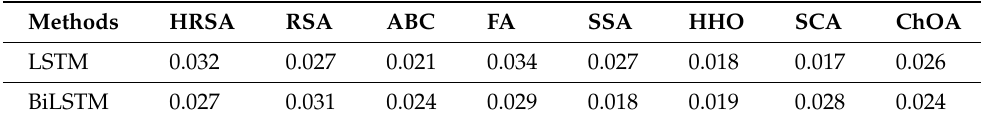
Table 10. Shapiro–Wilk p -values for LSTM and BiLSTM instances used to verify the normality requirement for safe application of parametric